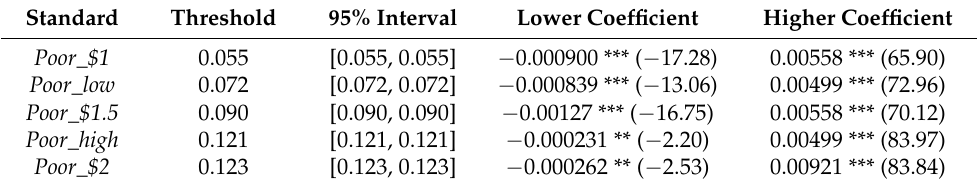
Table 25. Threshold estimates, confidence intervals, and coefficient